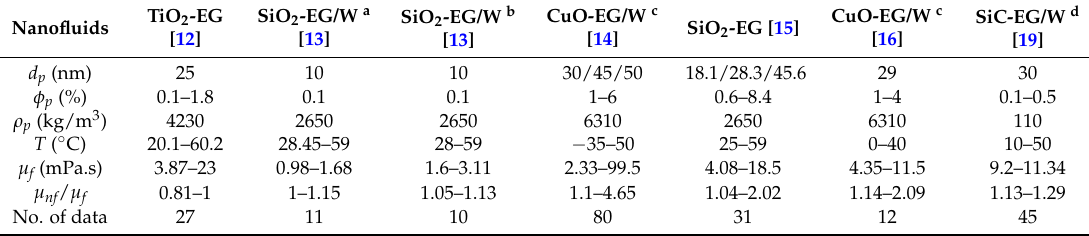
Table 1. Viscosity information of ethylene glycol/water based